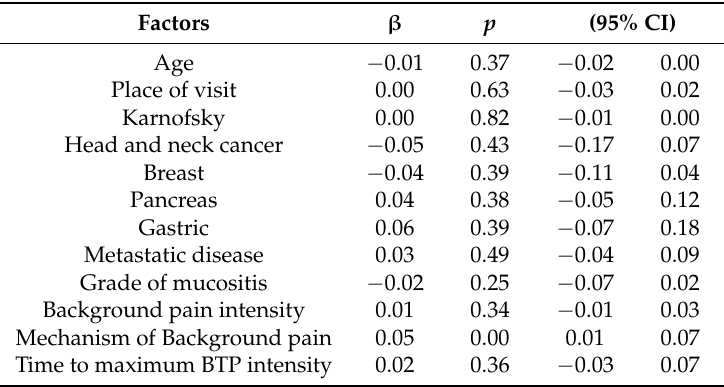
Table 4. Multivariate analysis for predictable